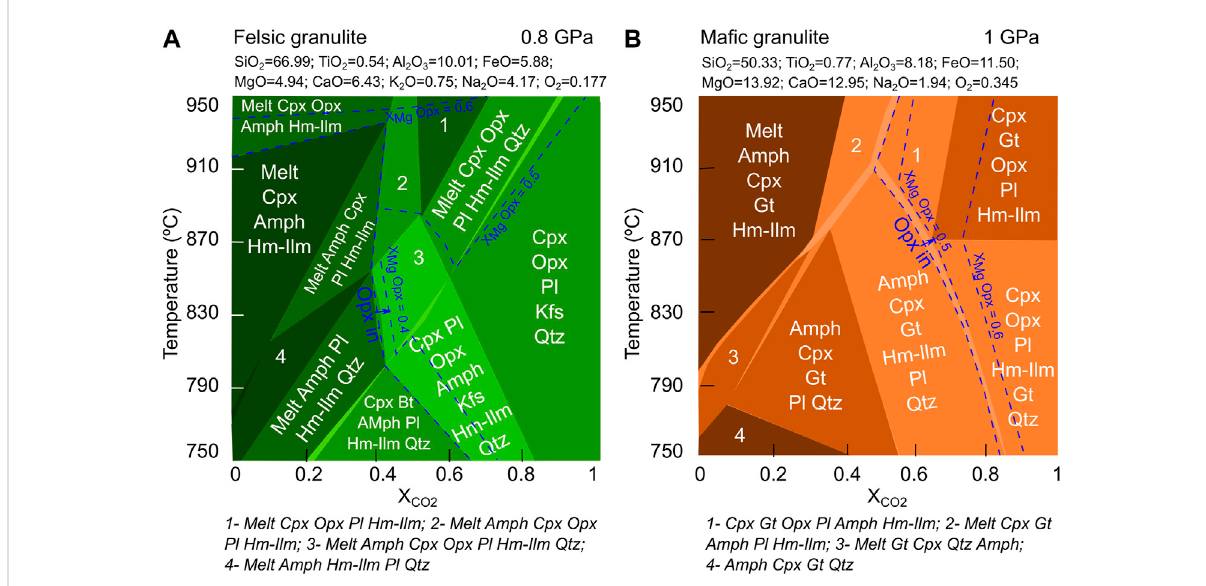
FIGURE 8 X CO2 -Temperature pseudosections modelled using compositions of felsic and ma fi c samples. (A) Pseudosection of felsic sample at 0.8 GPa. Blue dashed line represents orthopyroxene (X Mg ) composition. (B) Pseudosection of ma fi c sample at 0.8 GPa. Blue dashed line represents orthopyroxene (X Mg ) composition. Both pseudosections show that main mineral assemblage in both samples are stable at relatively high CO 2 concentration (X CO2 >